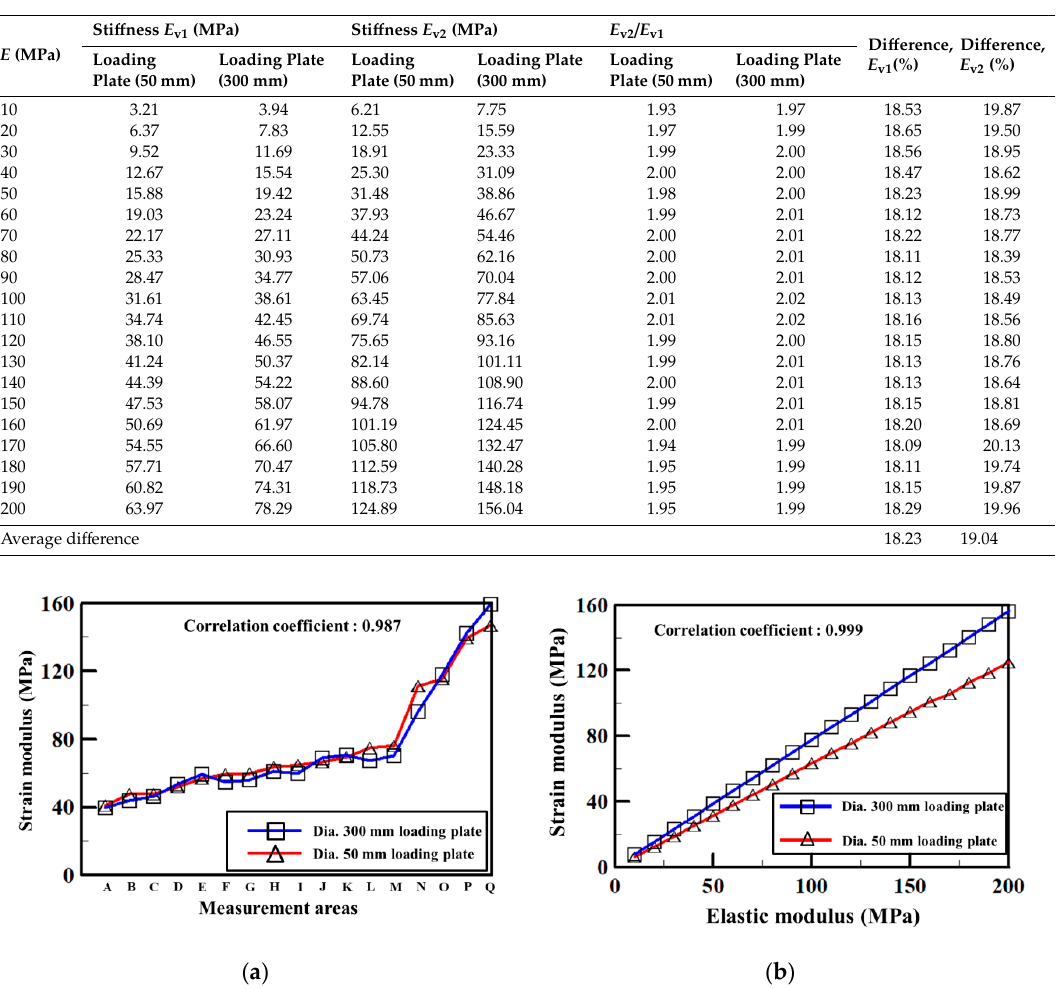
Table 4. Numerical analysis results of the field-test embankment roadbed.